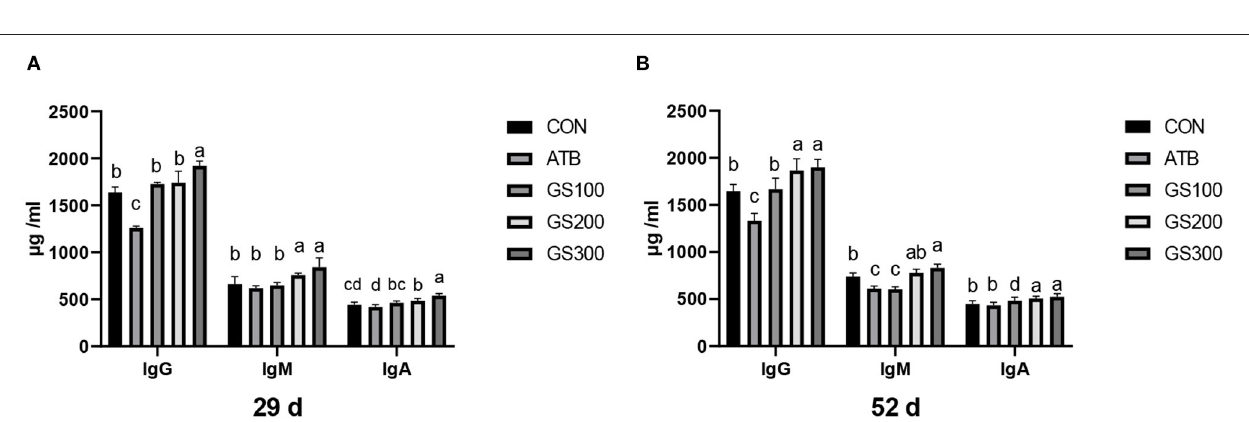
FIGURE 7 | Effects of Ginsenoside Rg1 on the relative phylum abundance of intestinal microbiota at day 29 (A) and day 52 (B) in broiler chickens ( n = 5). CON, birds fed a basal diet; GS100, birds fed a basal diet supplemented with 100 mg/kg ginsenoside Rg1; GS200, birds fed a basal diet supplemented with 200 mg/kg ginsenoside Rg1; GS300, birds fed a basal diet supplemented with 300 mg/kg ginsenoside Rg1; ATB, a basal diet supplemented with 300 mg/kg chlortetracycline.